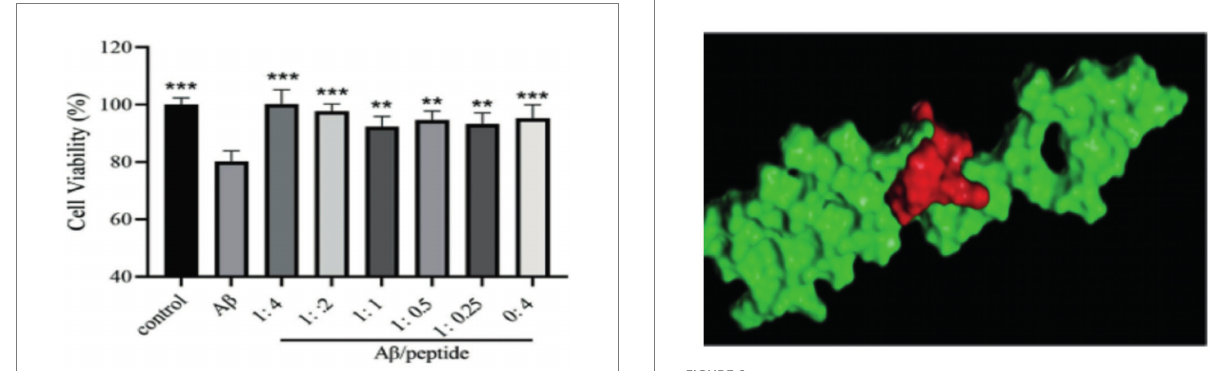
FIGURE 6 The three-dimensional structure diagram of the docking of the polypeptide and A β 1–42 , the red is the P21 in red, and the A β 1–42 is in green.